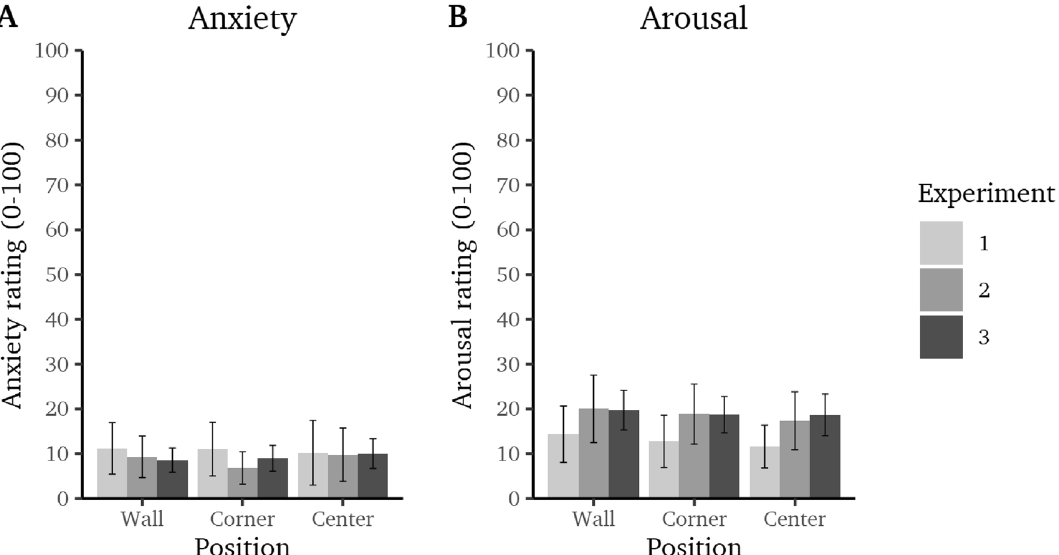
Figure 5. ( A ) Mean ratings of anxiety and ( B ) arousal at the center, corner, and wall of the open field in experiments 1–3 (± 95% Ratings. Repeated-measures ANOVA (with Greenhouse-Geisser correction of degrees of freedom if assump- tion of sphericity was violated) were used to compare the anxiety and arousal ratings at the center, corner, and wall positions respectively for each study. In all three experiments, the anxiety ratings did not differ between .846 , η 2 0.17 , p 1.13 , < .01 [0.00; 0.04]; experiment 2: F ( 1.51, 43.83 ) positions, experiment 1: F ( 2, 60 ) p = = = .04 [0.00; 0.11]; and experiment 3: F ( 1.75, 136.84 ) .317 , η 2 .449 , η 2 0.77 , p < .01 [0.00; 0.04] (see p p = p = = = .124 , 2.16 , p Fig. 5A). Likewise, the arousal ratings did not differ between positions: experiment 1, F ( 2, 60 ) = = .07 [0.00; 0.15]; experiment 2: F ( 1.53, 44.47 ) .02 [0.00; 0.08]; and experiment 3: .533 , η 2 0.55 , p η 2 p = p = = = .728 , η 2 0.32 , p < .01 [0.00; 0.02] (see Fig. 5B). F ( 2, 158 ) p = =